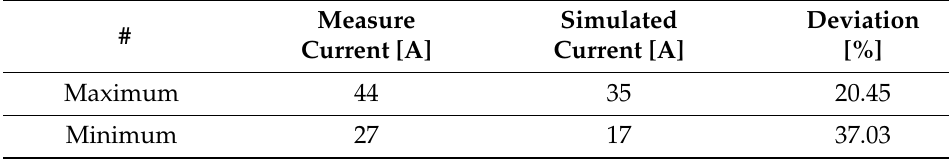
Table 5. Measured and simulated current values.